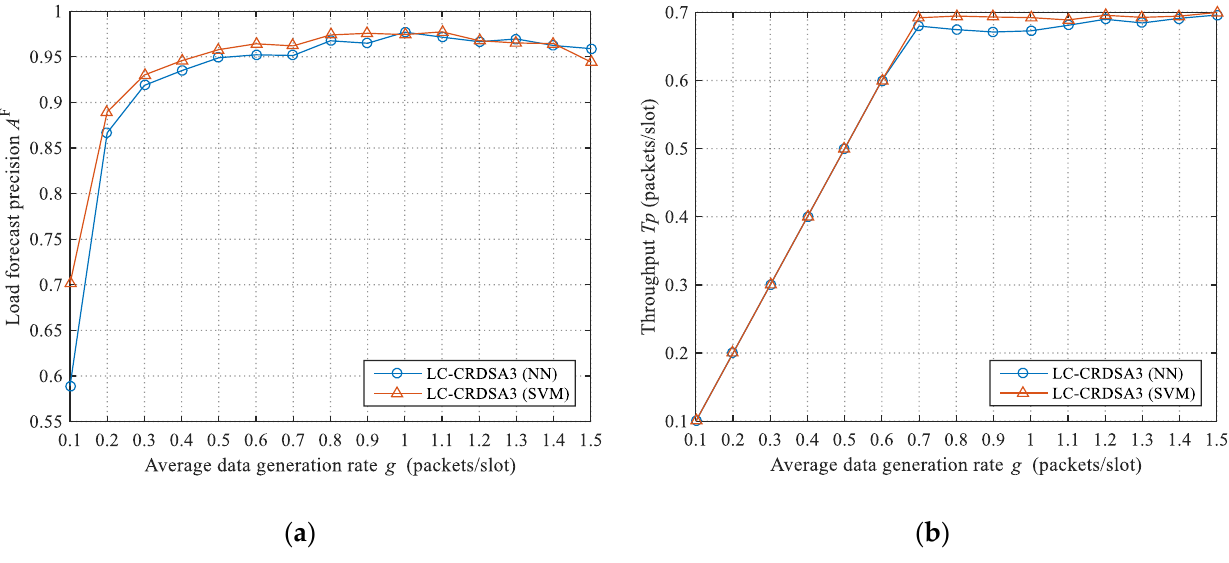
Figure 6. Load forecast precisions and throughput when using neural network and support vector machine for load forecasting: ( a ) Load forecast precisions under the two methods; ( b ) Throughput under the two methods.